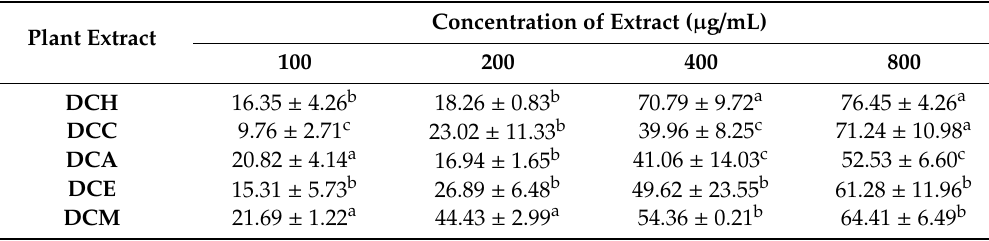
Table 5. Percentage of U251 cell growth inhibition by the extracts at di ff erent concentrations. Concentration of Extract ( µ g / mL) Plant Extract